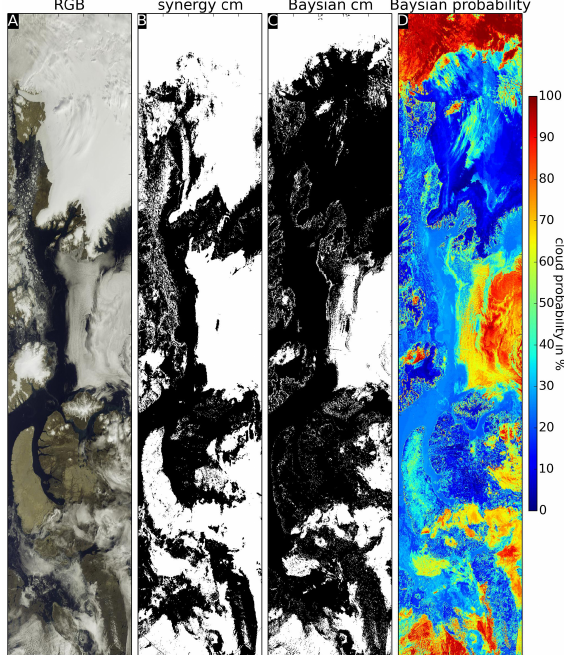
Figure 10. (a) shows an RGB view of a larger area of the scene which is shown in Fig. 1. (b) shows results of the non-Bayesian Synergy cloud mask with some classification errors over the top snow and ice region and the arrow-shaped land area in the bottom of the figure. (c) shows results of a Bayesian cloud mask which is based on corrected artificial truth from this scene and the one shown in Fig. 11. (c) shows the cloud probability results of this Bayesian cloud